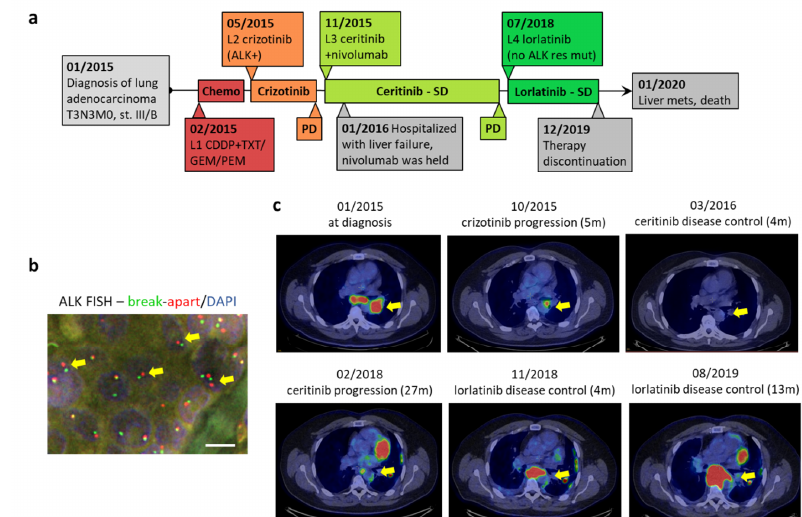
Figure 1. Case representation. ( a ) Time course of the case presented. First line chemotherapy of cisplatin+docetaxel (CDDP + TXT), then cisplatin + gemcitabine/pemetrexed (CDDP + GEM/PEM) was changed to 1st generation anaplastic lymphoma kinase (ALK) inhibitor after molecular diagnostic results. Following fast progression on crizotinib, a 2nd generation ALK inhibitor, ceritinib was started in combination with nivolumab. Due to liver damage, nivolumab was stopped two months later. Ceritinib resulted in disease control for 2.5 years. Upon progression, with no ALK resistance mutations detected, a 3rd generation ALK inhibitor, lorlatinib, controlled disease progression for 1.5 years until the patient stopped taking medication, that ultimately led to a fast development of fatal liver metastases. L1-4—treatment lines. PD—progressive disease. SD—stable disease. Mets—metastases. ( b ) Representative image of ALK FISH analysis. Yellow arrows at split signals indicate ALK rearrangement. Nuclei are stained with DAPI (blue). Scale bar: 5 µm. ( c ) Representative PET-CT slices showing pulmonary tumor mass in di ff erent time points. Numbers in brackets indicate months on treatment. Yellow arrow indicates tumor